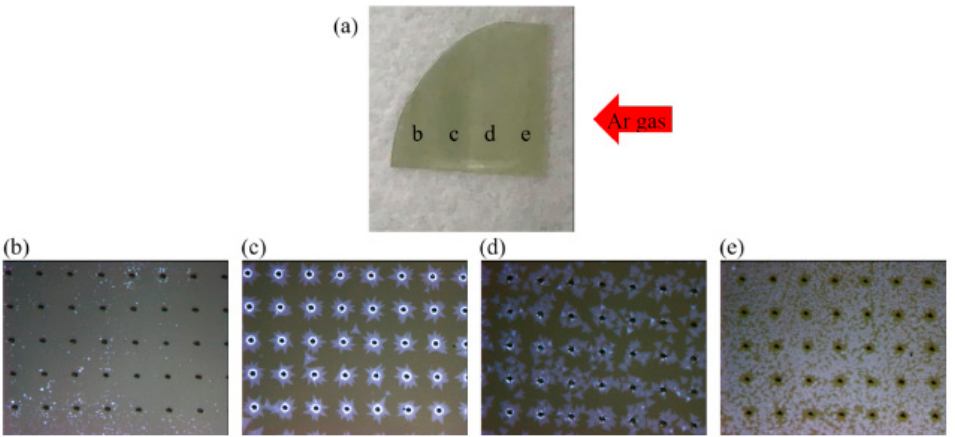
Figure 3. ( a ) Image of sapphire substrate after MoS 2 growth. ( b ) OM image at position b in ( a ). ( c ) OM image at position c in ( a ). ( d ) OM image at position d in ( a ), and ( e ) is the OM image at position e in ( a ).